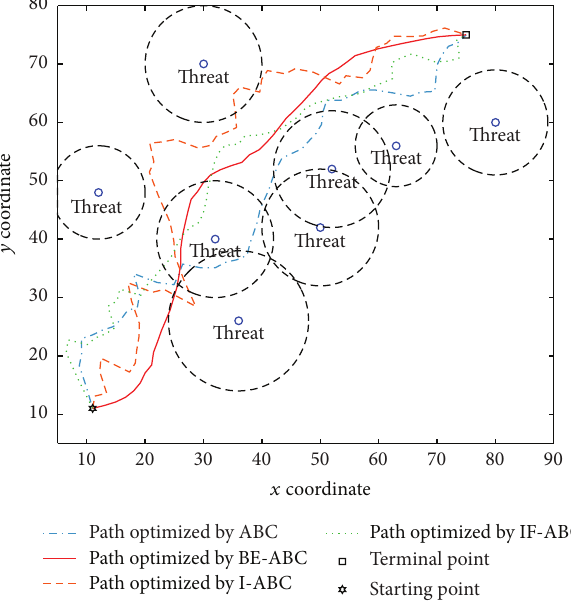
Figure 4: Comparative path planning results optimized by different ABC relevant algorithms in Case 1 ( 𝐷 = 50 ).